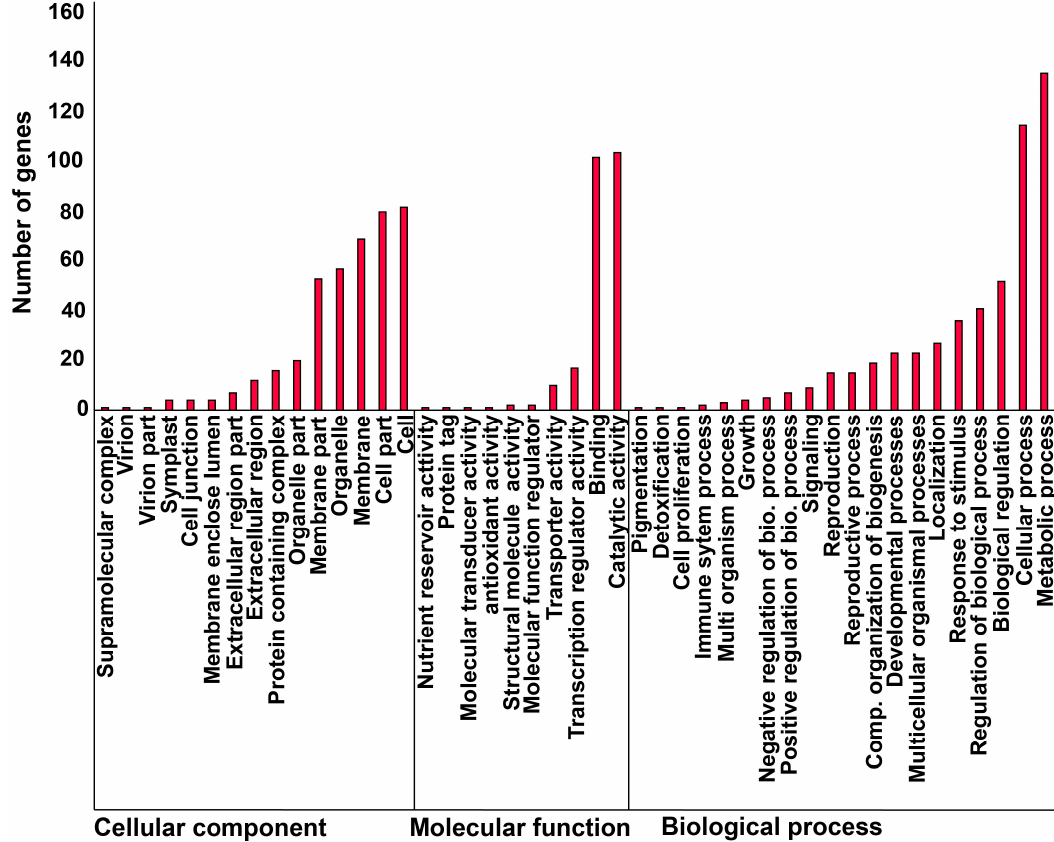
Figure 5. Gene ontology (GO) distribution for genes in close proximity to elements of different CACTA families. GO terms were subdivided into three major ontology classes: cellular component, molecular function, and biological process.